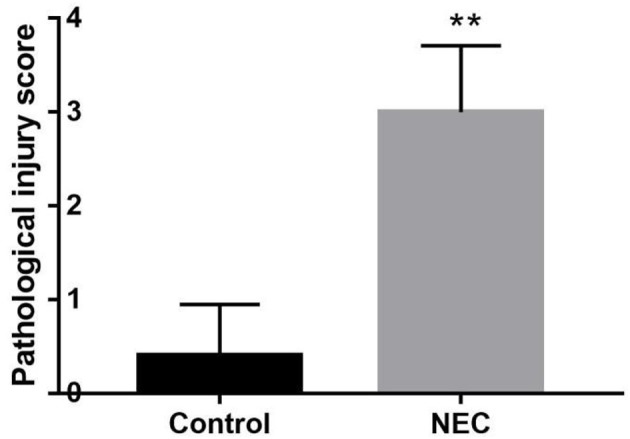
Comparison of intestinal histopathological injury scores between NEC group mice and control group mice **P < 0.05.